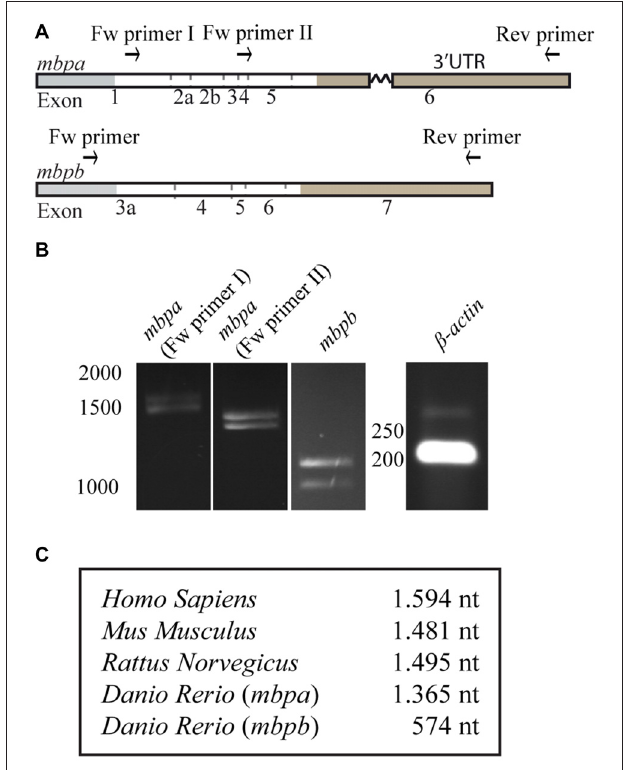
FIGURE 3 | The length of the 3’UTRs is markedly different between mbpa and mbpb . (A) Schematic illustration of the regions recognized by primers used for RT-PCR. (B) RT-PCR with RNA extracted from zebrafish larvae at 96 hpf as template. The identity of primers is indicated above the gel pictures. A primer set for β -actin was included as a control. (C) Table showing the lengths of the 3’UTRs of selected species. For mbpa and mbpb the lengths of the longest predicted 3’UTR are shown. Results are representative of two individual experiments.